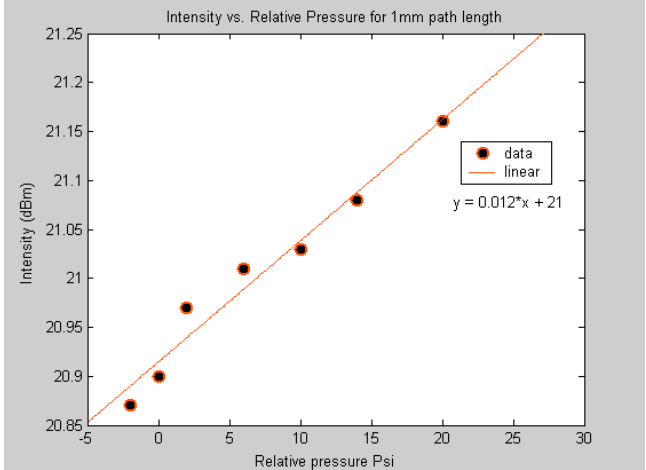
Figure 7. Intensity vs. Pressure for 1mm path length (25 µm bore size).